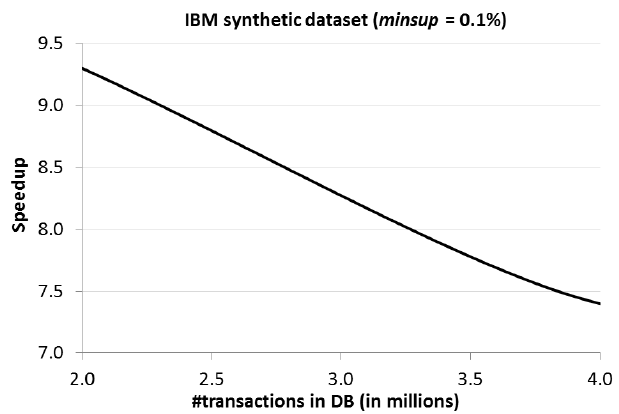
Figure 3. Speedup vs. #transactions.